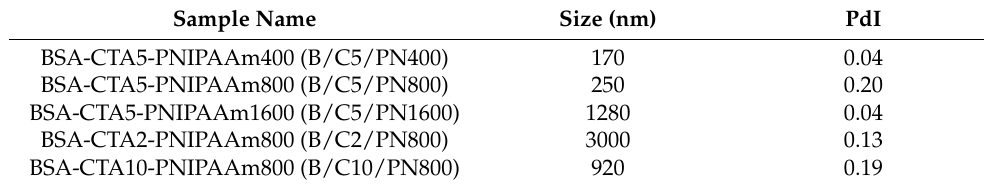
Table 3. DLS results of each